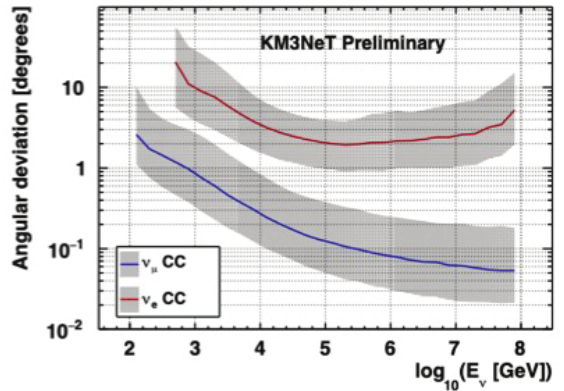
Figure 3: Angular resolution for ARCA track-like events (from ν μ charged current interactions) and shower-like events ( ν e charged current interactions), as a function of the neutrino energy.